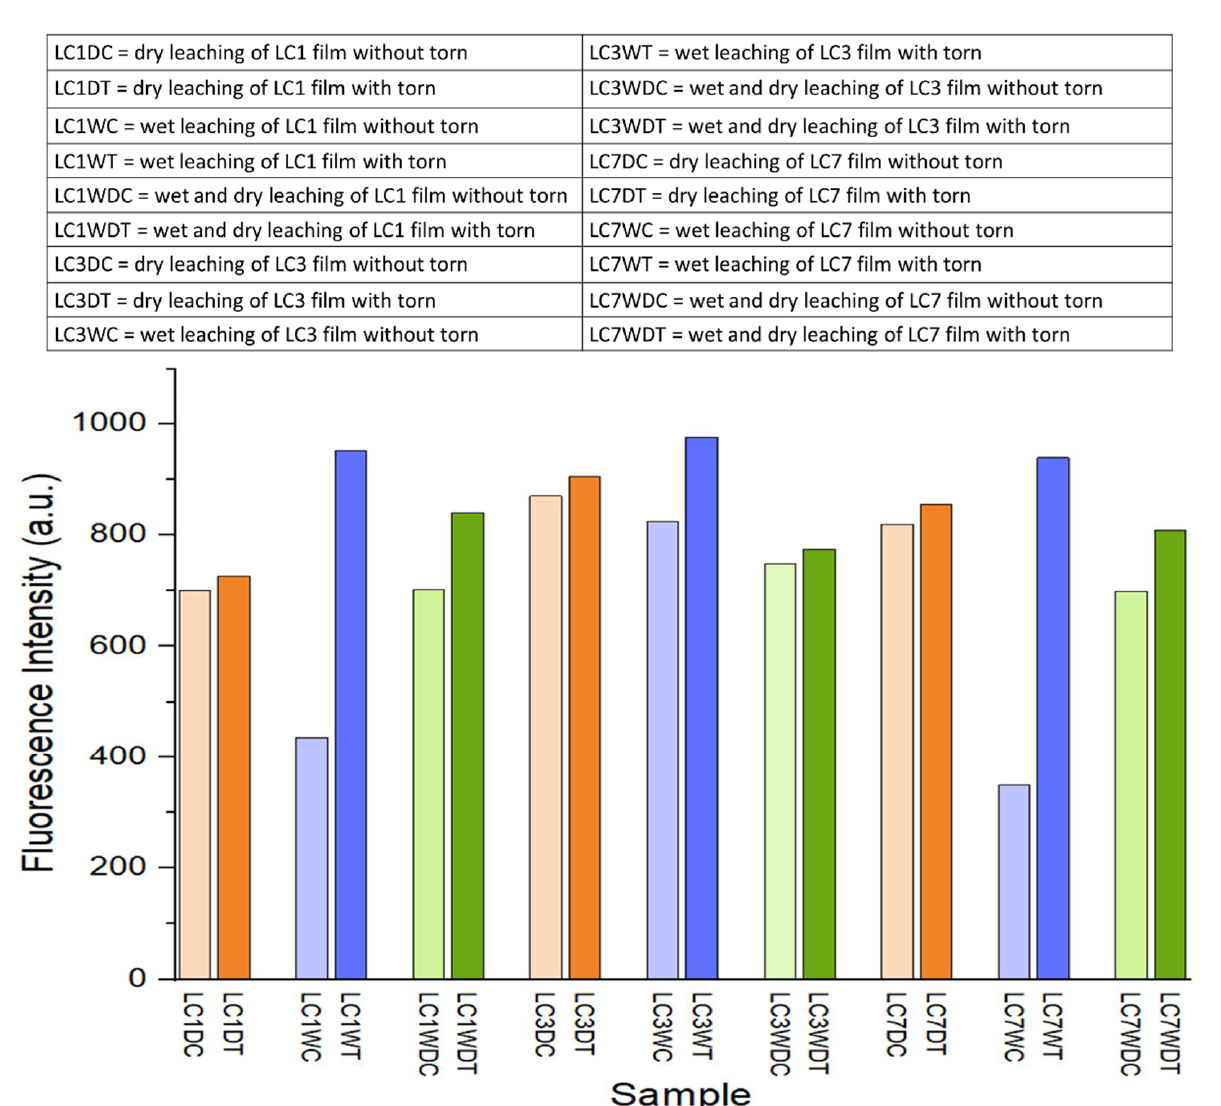
Figure 5. The fluorescence intensity of each sample after leaching at emission wavelength 510 nm. Table 4. Images of LC1, LC3, and LC7 torn film before and after leaching.